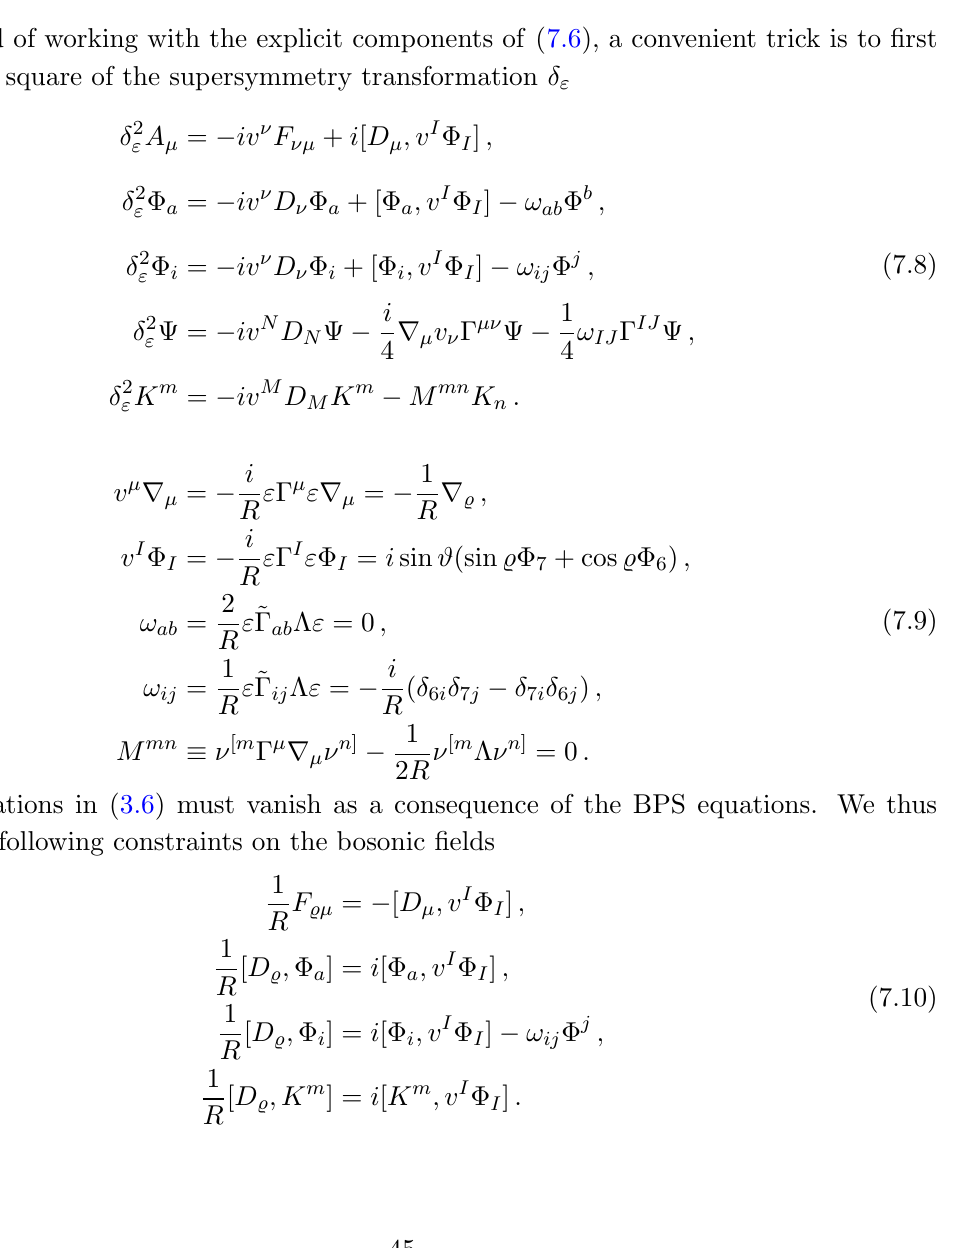
Figure 4. S 5 viewed as a (cid:12)bration of S 1 at # =